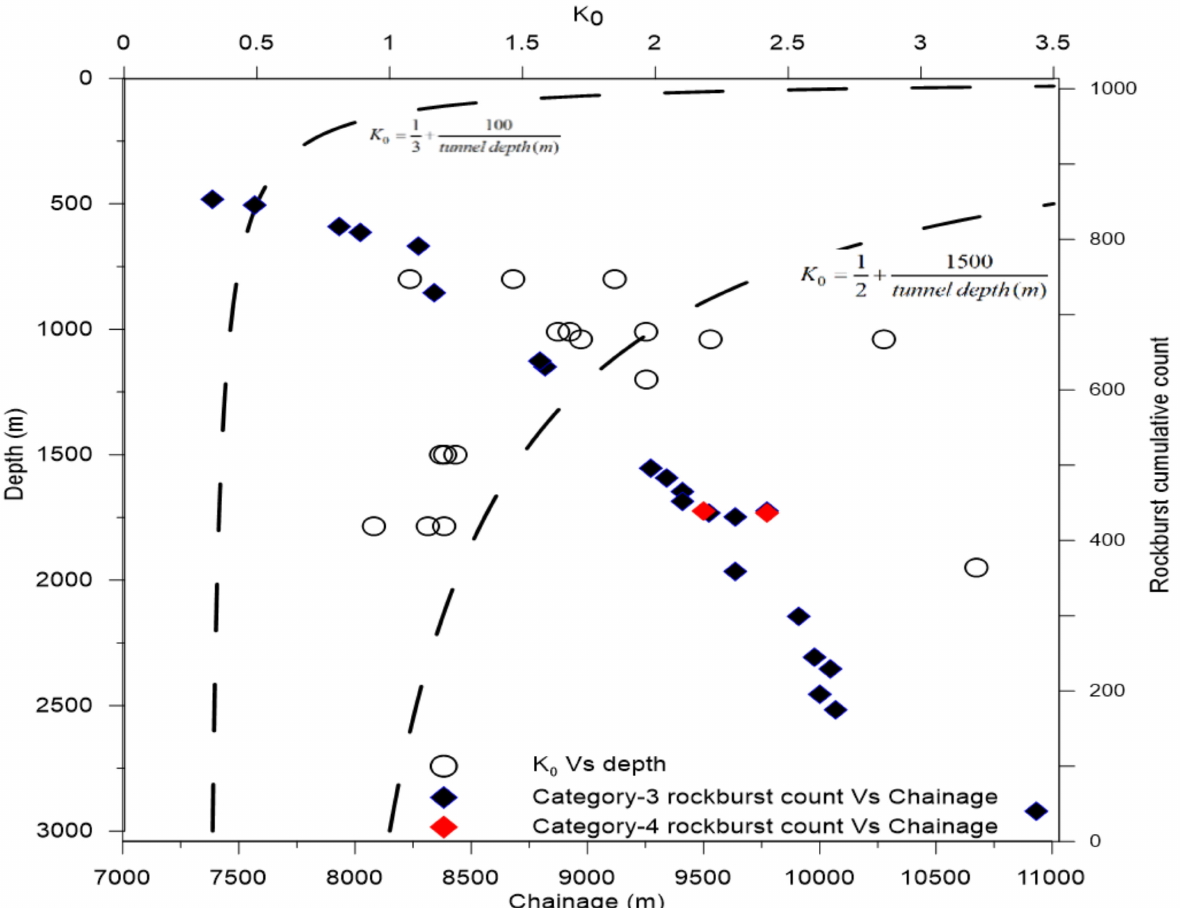
Figure 7. High in-situ stresses due to tectonics and the rock burst count in the headrace tunnels due to these stresses in the area (modified after